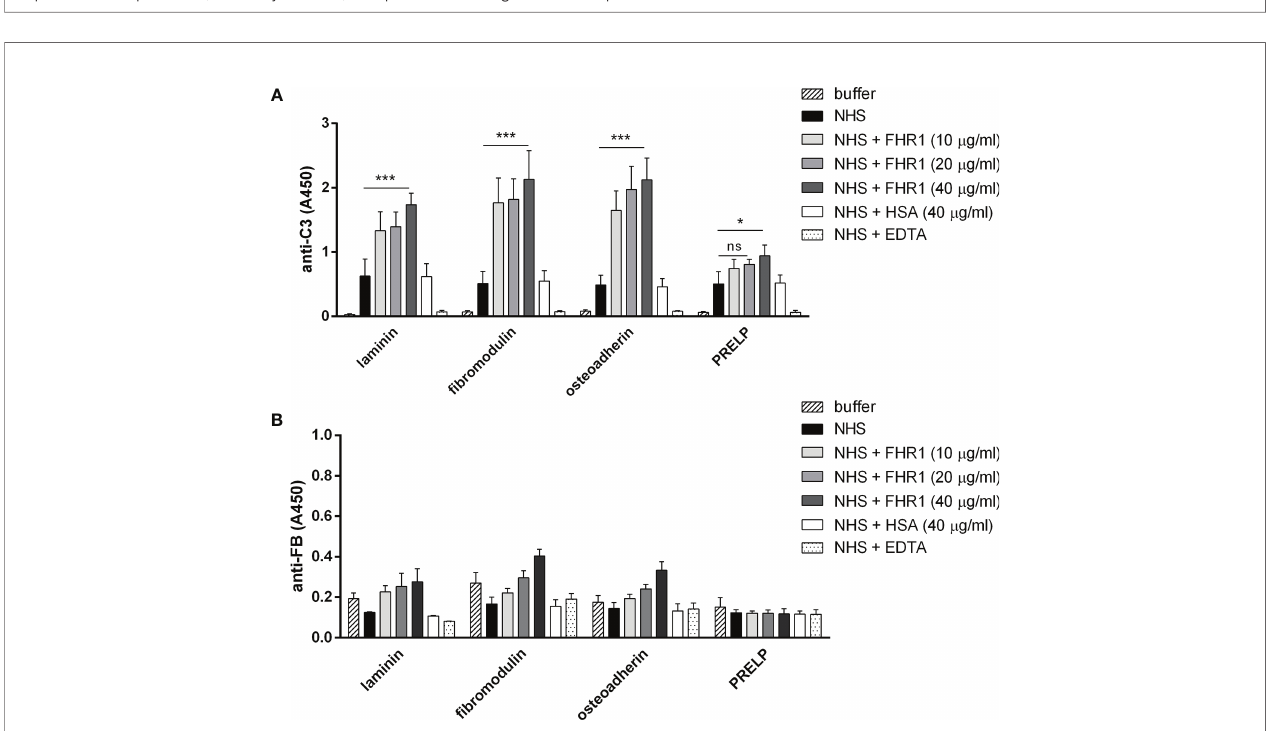
FIGURE 7 | FHR1 increases C3 fragment deposition on ECM proteins. Immobilized ECM proteins were incubated with 10% NHS with or without FHR1 added in increasing concentrations (10 µg/ml, 20 µg/ml, 40 µg/ml) diluted in 5 mM Mg 2+ -EGTA. C3 fragment deposition (A) was measured with HRP-conjugated polyclonal anti-human C3 Ab and FB binding (B) was measured by goat anti-human FB and the corresponding secondary Ab. Data are means ± SD derived from four independent experiments. *p <0.05, ***p < 0.001, two-way ANOVA; ns, not signi fi